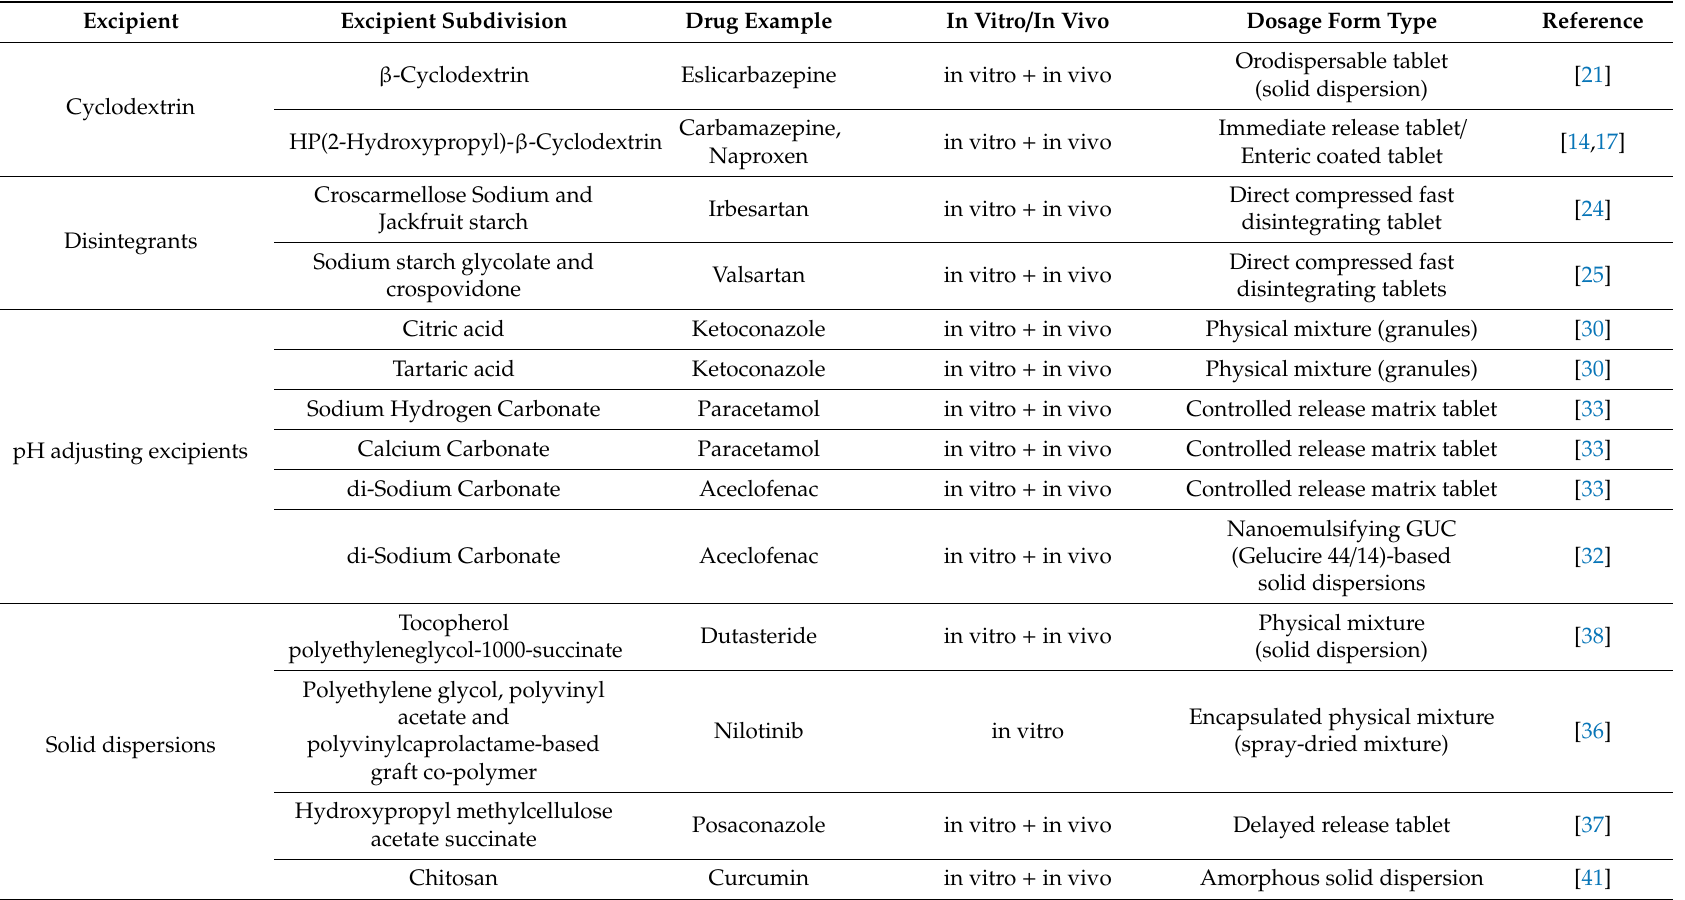
Table 1. Summary of functional excipients used in di ff erent types of dosage forms to improve drug solubility and dissolution